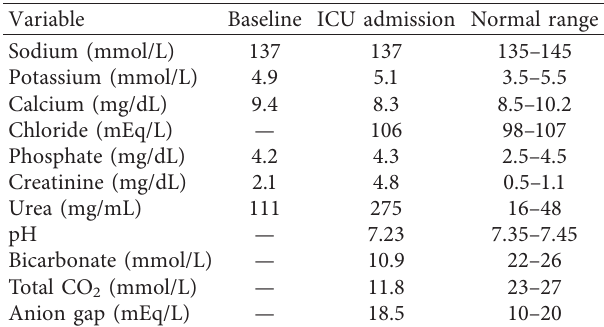
Table 1: Laboratory values at baseline (before surgery) and at ICU